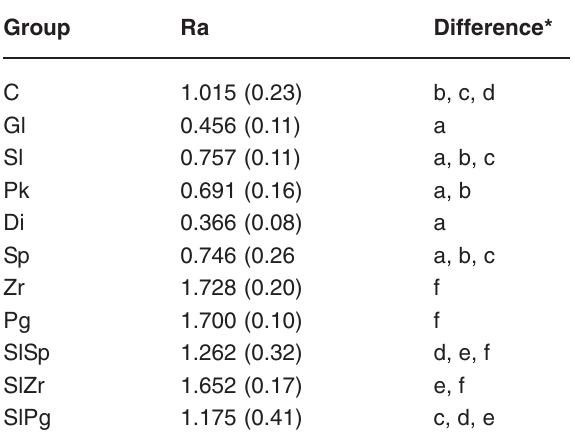
Table 4- Mean (SD) of surface roughness and differences between groups for Matchmaker MC porcelain